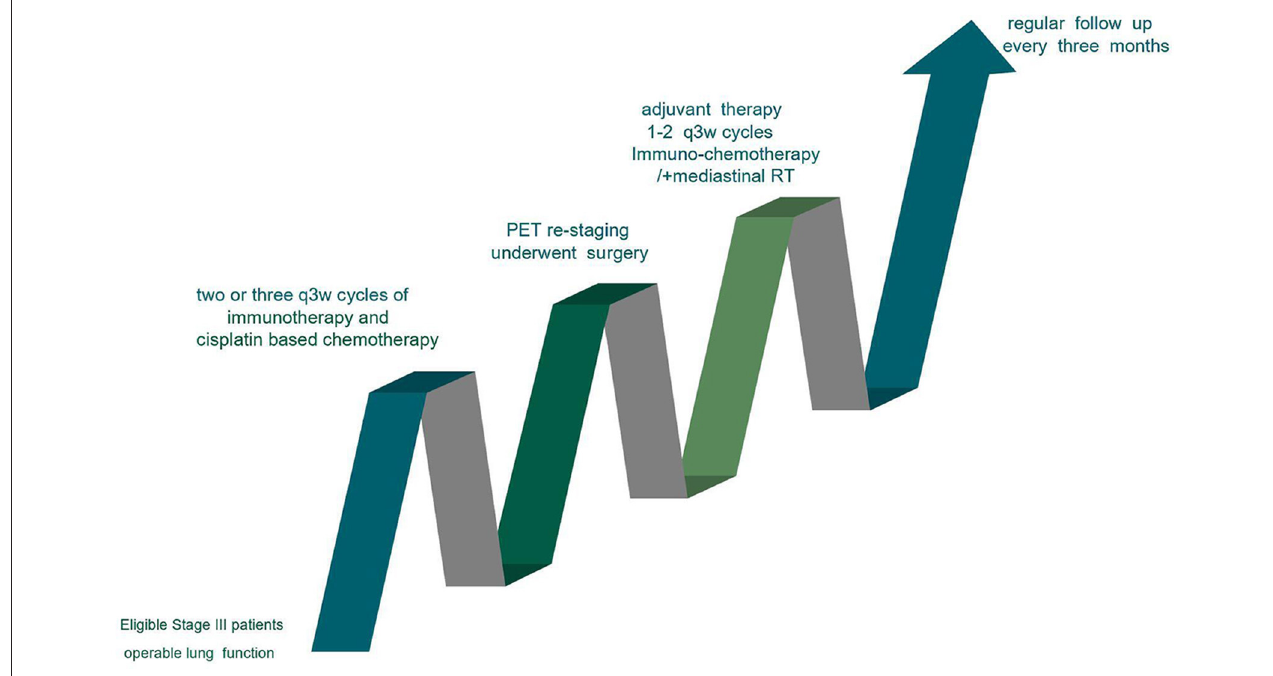
FIGURE 1 | Standard procedure for the treatment of resectable stage III